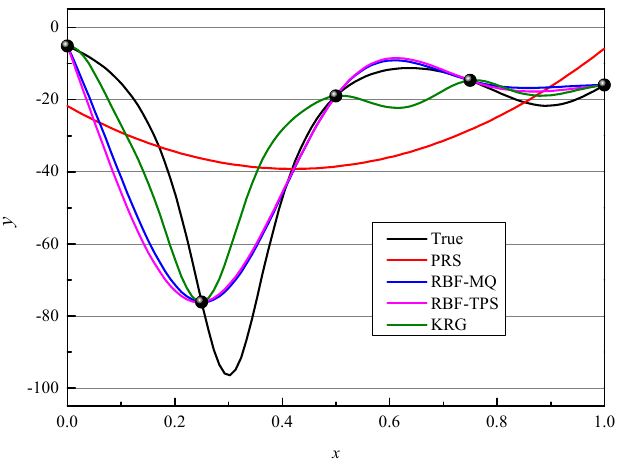
Figure 3. Comparison of four surrogate models. Table 3. Ranking results of surrogate models by MOA-CV and LOO-CV methods.